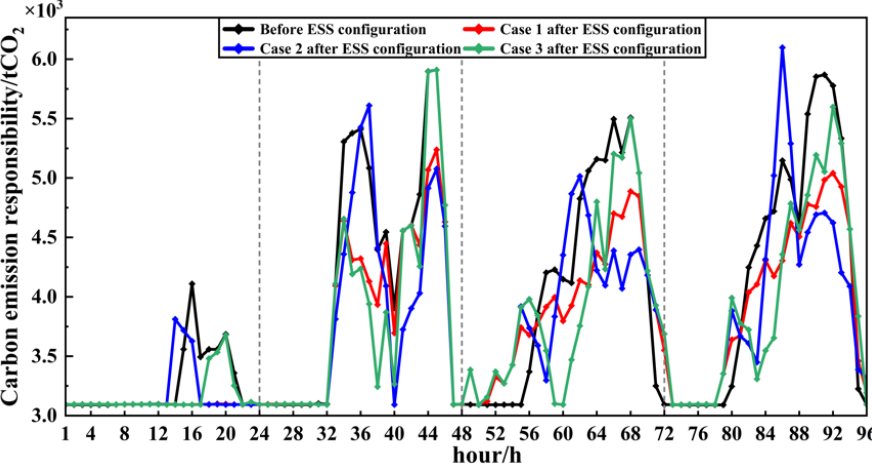
Figure 14. The total power load before and after the EES configuration in three cases.